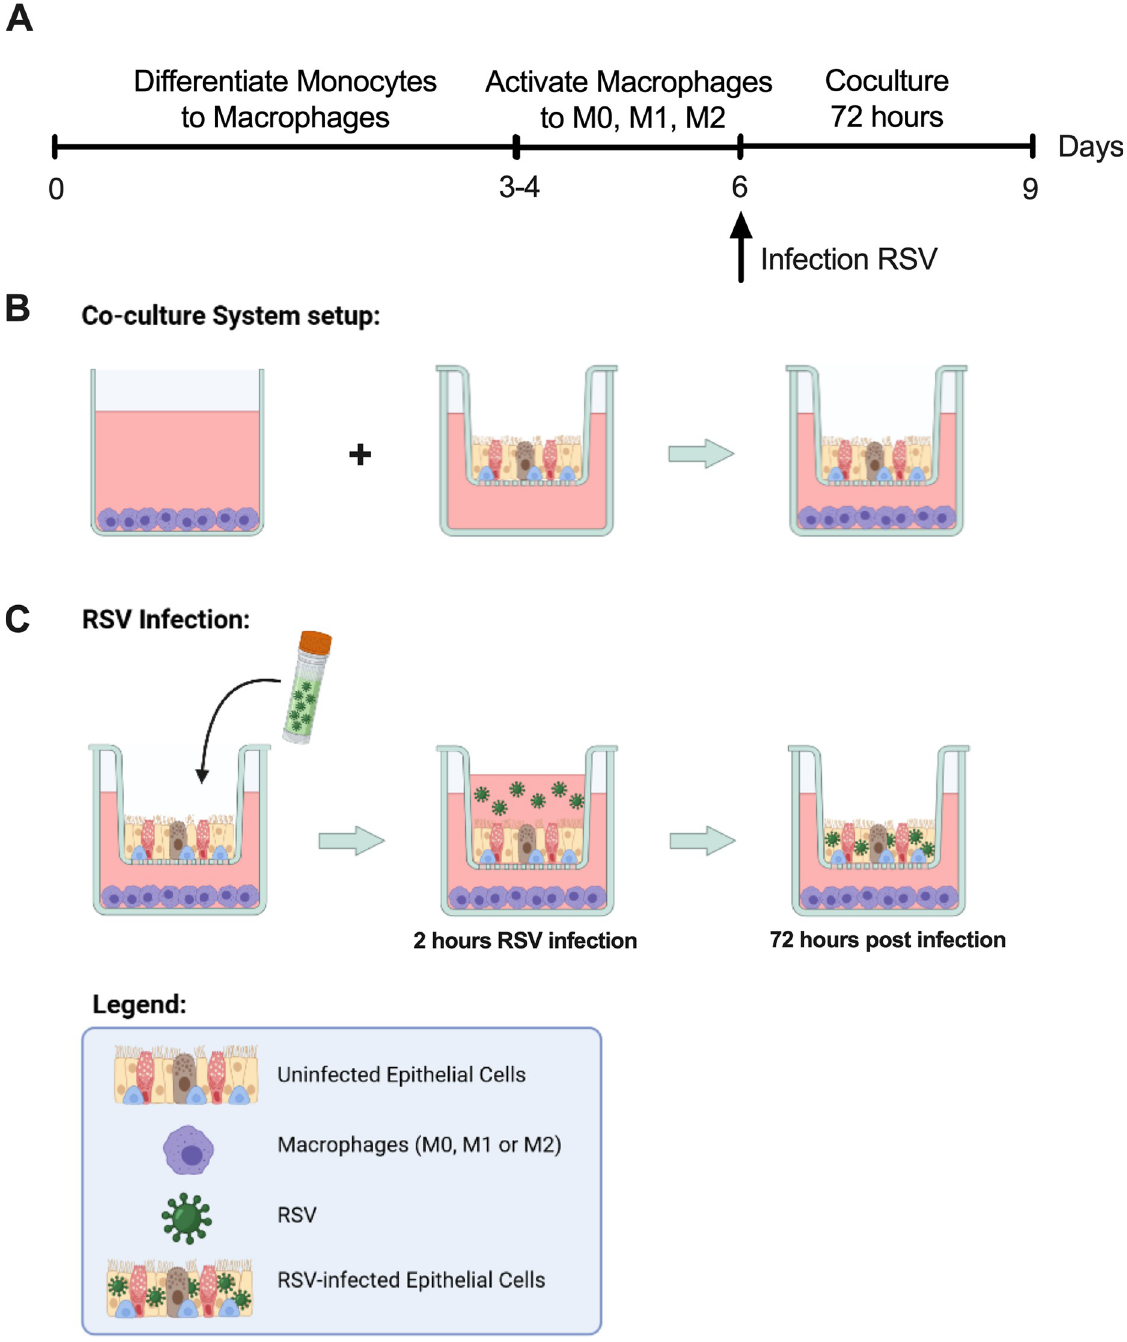
Fig 1. Methods for macrophage differentiation, co-culture, and RSV infection. (A) The timeline of monocyte differentiation into macrophages, then into M0, M1-like, or M2-like macrophages. Human blood-derived monocytes were isolated from enriched leukapheresis product and cultured in IMM. Monocytes were differentiated into naive (M0-like) macrophages using IMM with 50 ng/mL M-CSF for 3–4 days, and further differentiated for 2–3 days into M1- or M2-like macrophages through addition of 50 ng/mL IFN γ and 10 ng/mL LPS, or 10 ng/mL IL-4. Cells were then placed in co-culture with human HBECs for 72 hours. In some instances, the epithelial cells were infected with RSV immediately after being placed in co-culture. (B) A schematic of the macrophages and HBECs being placed in co-culture. The HBECs were maintained at air-liquid interface and the macrophages were in submerged culture at the bottom of the dish. The macrophages and epithelia were not in direct contact. (C) Illustration of co-culture with RSV infection. After cells were placed in co-culture the epithelia were infected by the apical addition of medium containing RSV and incubated for 2 hours; then the inoculum was removed and the epithelia returned to air-liquid interface. The cultures were collected after 72 hours.